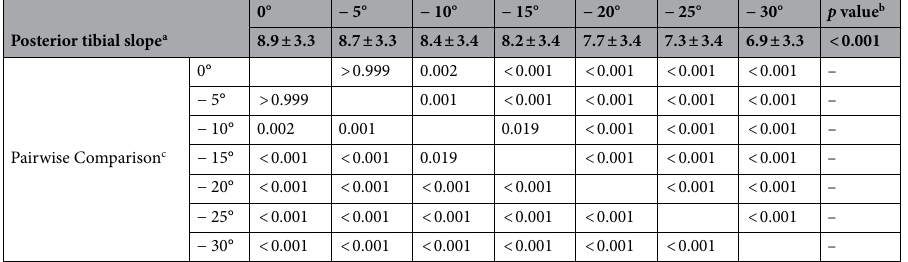
Table 4. Comparison between the postoperative posterior tibial slopes measured on the 3D models where the posteriorly inclined osteotomy and pairwise comparison. a The values are presented as mean ± standard deviation. b Analyzed by repeated measured analysis of variance (ANOVA). c Adjusted p value obtained by Bonferroni correction.